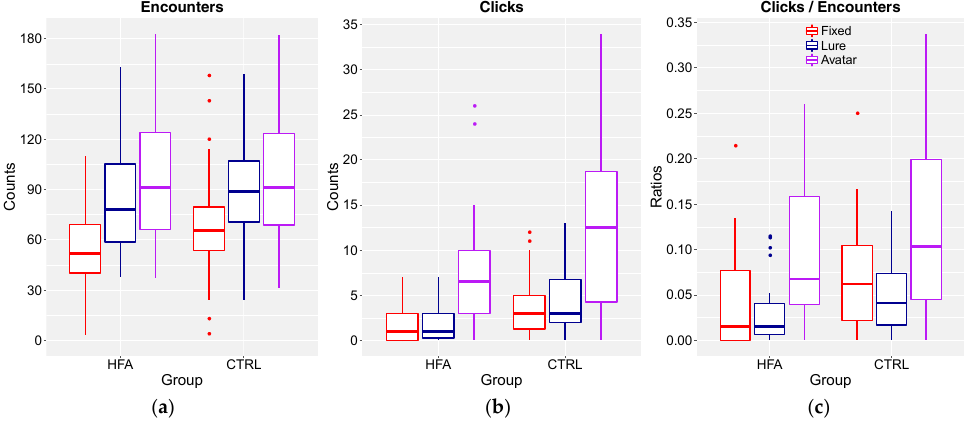
Figure 4. Box-whisker plots of the number of (a) encounters, (b) clicks, and (c) the clicks to encounters ratios. The different colors indicate the object types. Each box represents 30 observations. The middle line inside each box corresponds to the median. The whiskers are in Tukey style (outliers are 1.5 × IQR above or below from the edge of the box). The complete data per dyad/participant and condition, as well as R script, can be found at https://osf.io/h4nkr/.